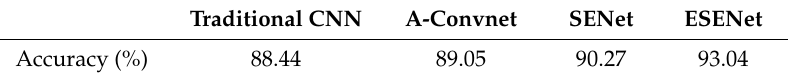
Table 7. Recognition accuracy comparison under EOC1.